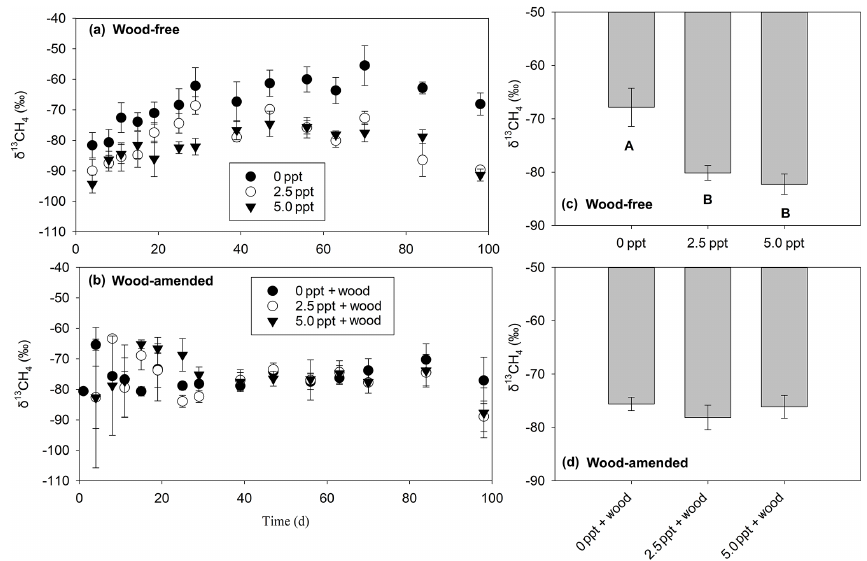
Figure 5. The δ 13 CH 4 values measured over the course of the 98d laboratory incubation for wood-free soils (a) and wood-amended soils (b) and the average δ 13 CH 4 across the entire incubation for wood-free soils (c) and wood-amended soils (d) . Symbols or bars represent the mean with standard error ( n = 4). Treatment means with different lowercase letters are significantly different within a sampling time point ( P < 0 .